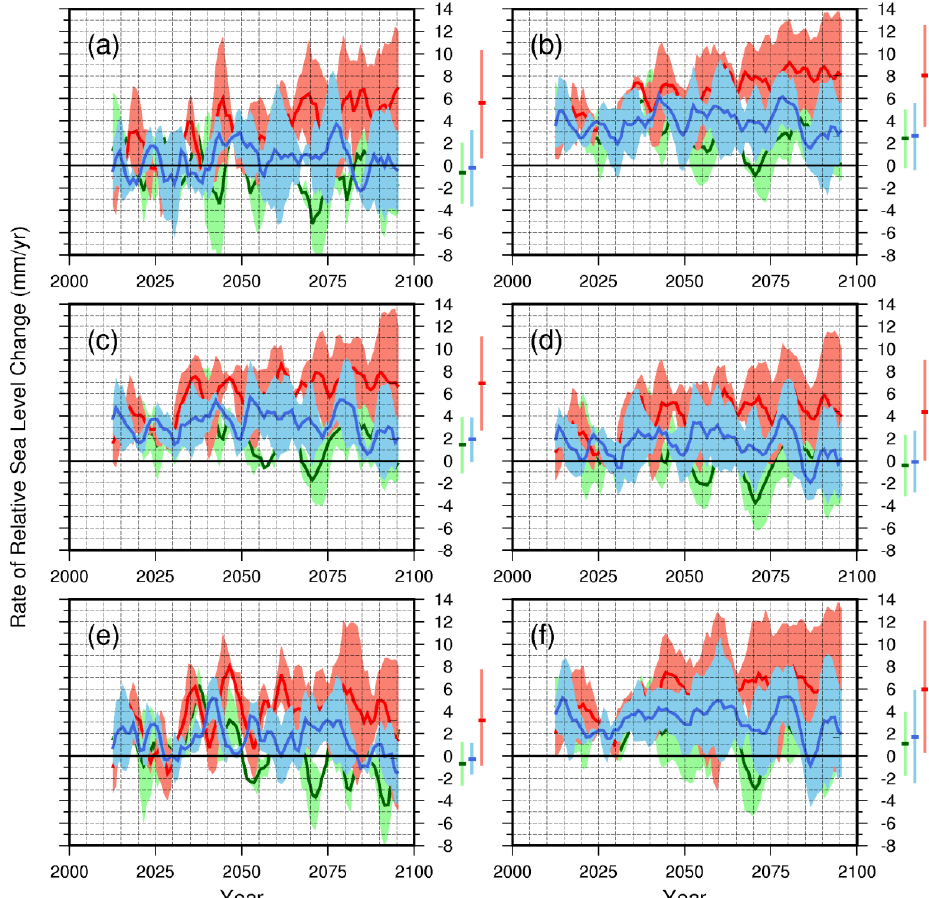
Figure 11. Projected rates of sea-level change for RCP2.6 (green), RCP4.5 (blue) and RCP8.5 (red) for the six key locations: ( a ) Oslo; ( b ) Stavanger; ( c ) Bergen; ( d ) Heimsjø; ( e ) Tromsø; and ( f ) Honningsvåg. Rates are calculated as linear trends over a 10-year moving window, the x-axis represents the mid-point of each window. The vertical bars on the right side of the panels represent the ensemble mean and ensemble spread (5% to 95%) for rates calculated for the period 2081 to 2100.